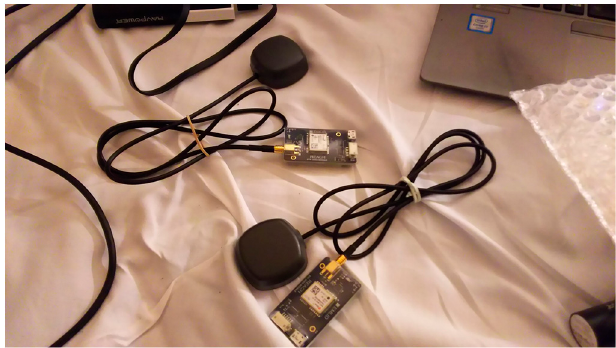
Figure 4. Small and light-weight global navigation satellite system (GNSS) equipment for post- processing kinematic